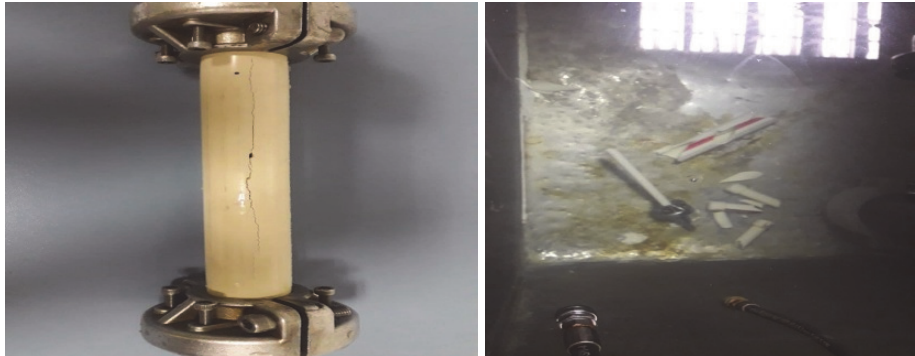
Figure 5: Rupture form of CPVC